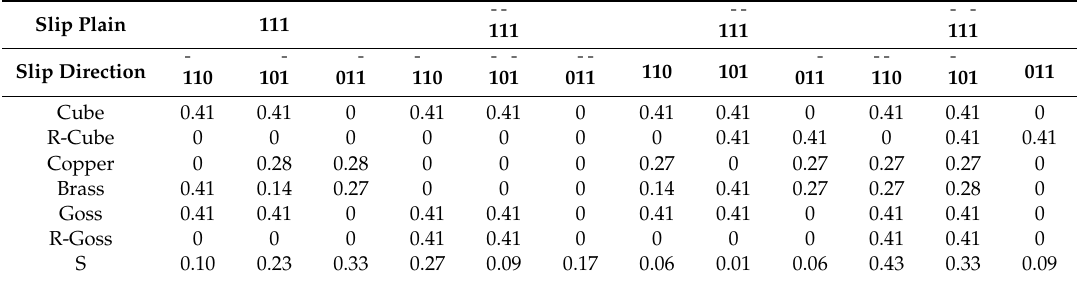
Table 6. Schmid factor of textures corresponding to the {111} < 110 > slip system in the Al